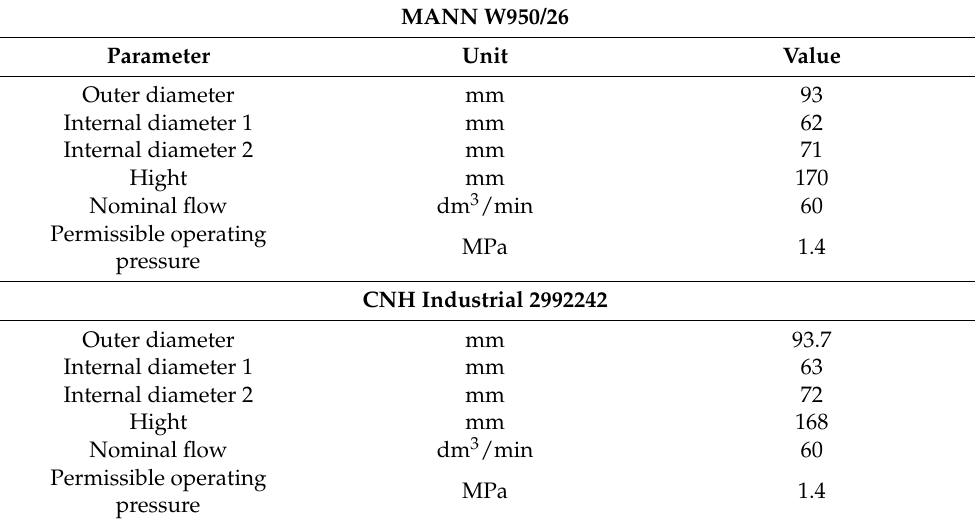
Figure 2. Connection of flow and pressure sensors on the laboratory test equipment before and after the oil filters in the hydraulic circuit A and B. Table 2. Parameters of oil filters. Table 1. Basic data of flow, pressure, and temperature sensors [15].